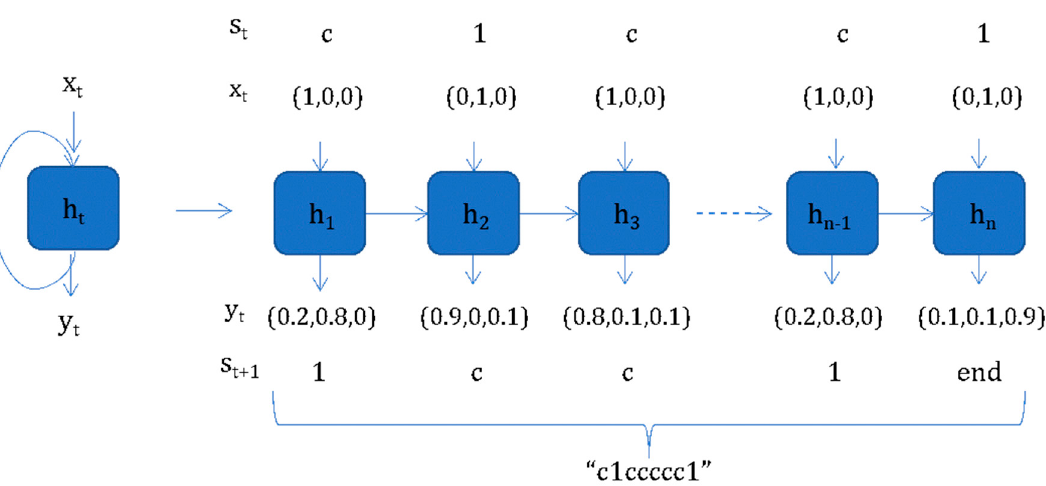
Figure 5. Architecture of recurrent neural networks. The inputs are represented by x t . For the standard RNN, the hidden state at time step t is represented as s t .; is the “memory” of the network, and for time step t, s t is calculated based on the previous hidden state and the input at the current step: s t = f(Ux t + Ws (t − 1) ). The function f is usually a nonlinearity, such as tanh or Rectified Linear Unit (ReLU).